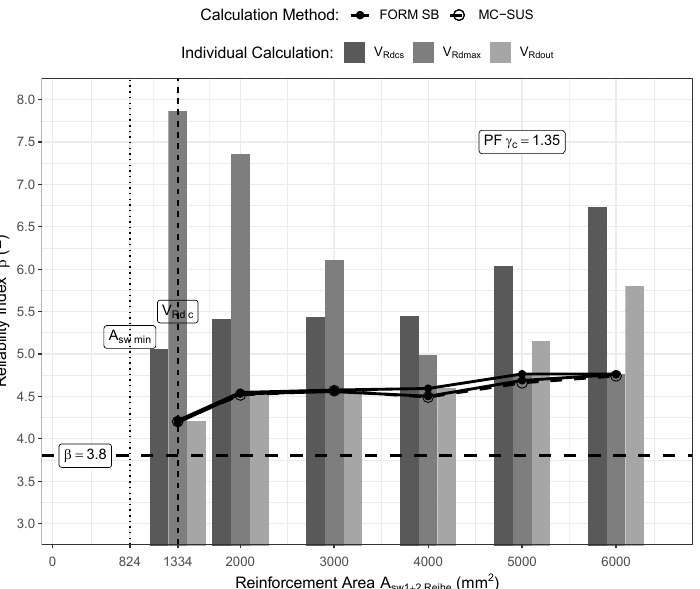
Figure 5. Systems reliability analysis for a partial factor 𝛾 (cid:3004) of 1.35.